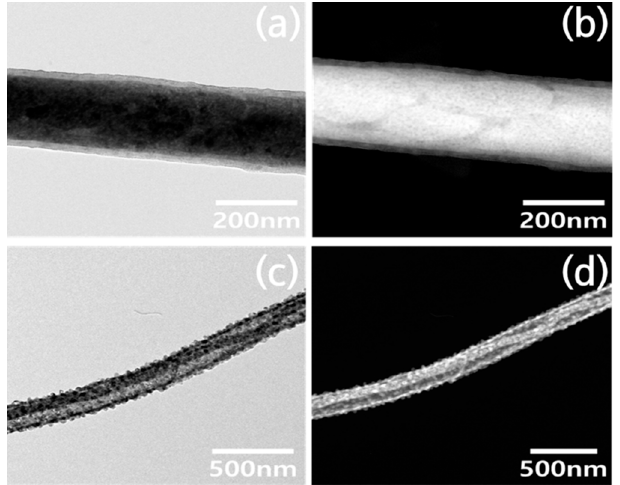
Figure 4. TEM images of nanofibers obtained from each precursor solution: ( a ) bright-field images (BF) of the TiO 2 nanofiber, ( b ) high-angle annular dark-field images (HAADF) of the TiO 2 nanofiber, ( c ) BF images of the Fe-doped TiO 2 nanofiber, and ( d ) HAADF images of the Fe-doped TiO 2 nanofiber.